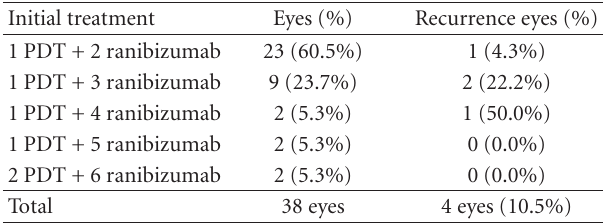
Table 2: Recurrence rates of exudative changes after successful ini- tial